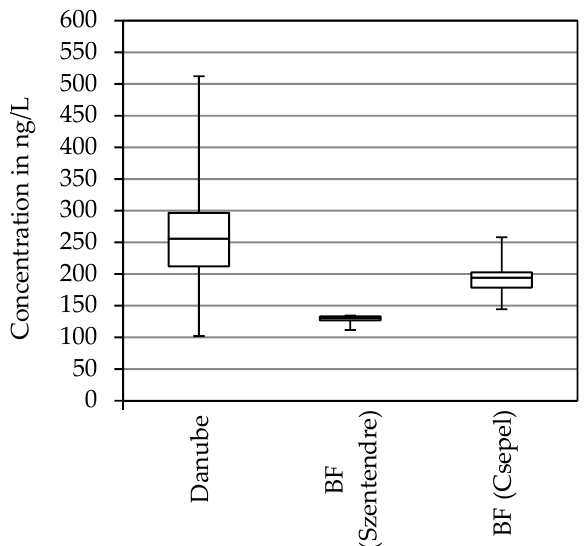
Figure 7. Boxplots representing concentrations of acesulfame in the Danube River water and bank filtrate.